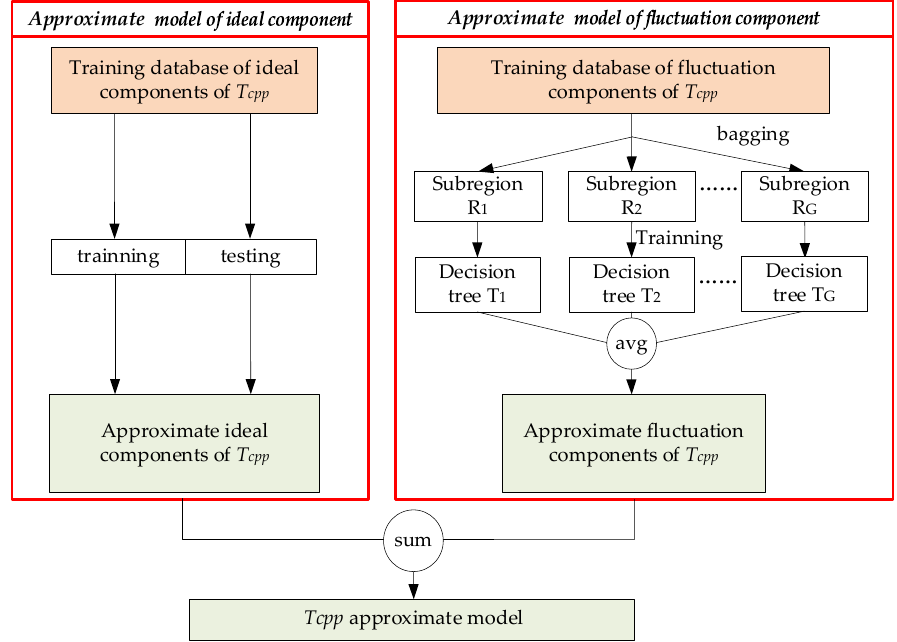
Figure 5. The flow chart of the compensate fluctuation (CF) approximate modeling